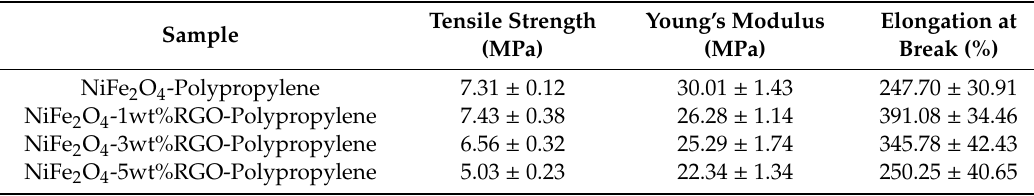
Figure 15. Strain–stress behavior of ( a ) polypropylene and ( b ) prepared polypropylene nanocomposites. Table 2. Mechanical property parameters: Tensile strength, Young’s modulus, elongation at the break of prepared composite